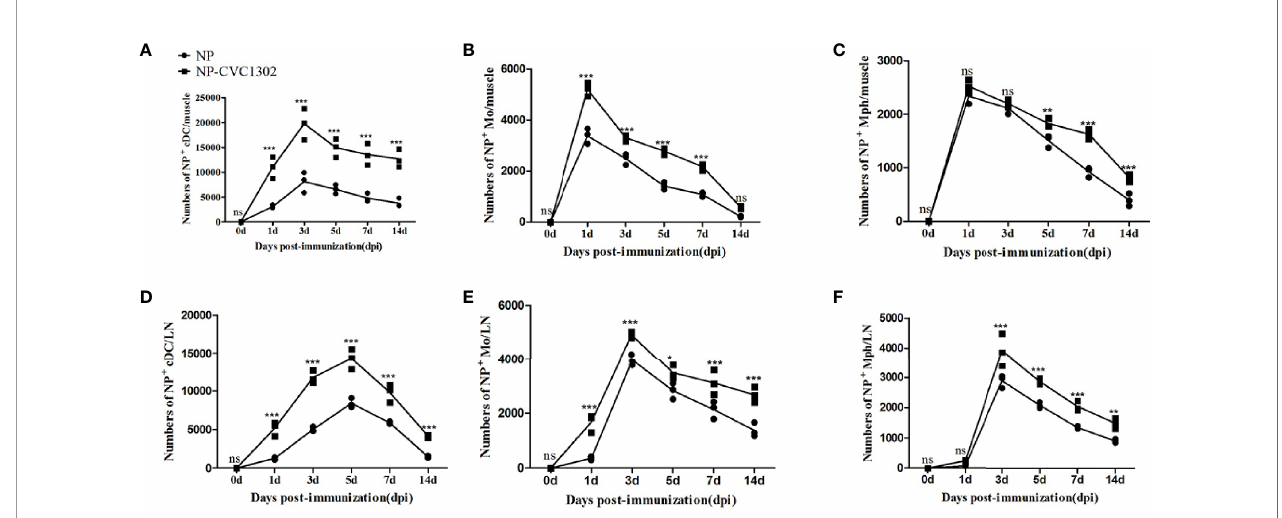
FIGURE 1 | The in fl ux of NP+ APCs at injection sites and translocation of NP+ APCs to draining LNs. Samples were collected at 1, 3, 5, 7, and 14 dpi from mice treated with the immunization protocol described in the Materials and Methods. (A) The numbers of NP+ DCs at injection sites. (B) The numbers of NP+ Mo at injection sites. (C) The numbers of NP+ Mph at injection sites. (D) The numbers of NP+ DCs in draining LNs. (E) The numbers of NP+ Mo in draining LNs. (F) The numbers of NP+ Mph in draining LNs. Values show the mean ± SEMs of 3 muscles from 3 mice per treatment group. * P < 0.05, ** P < 0.01, *** P < 0.001, ns, not signi fi cant.